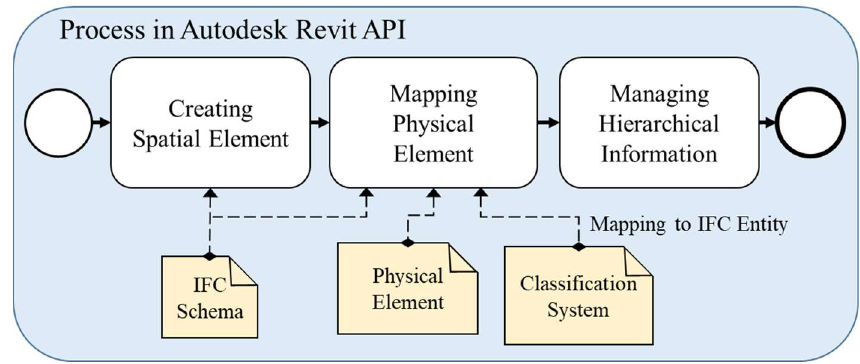
Figure 5. Process for creating hierarchical information using Autodesk Revit API.